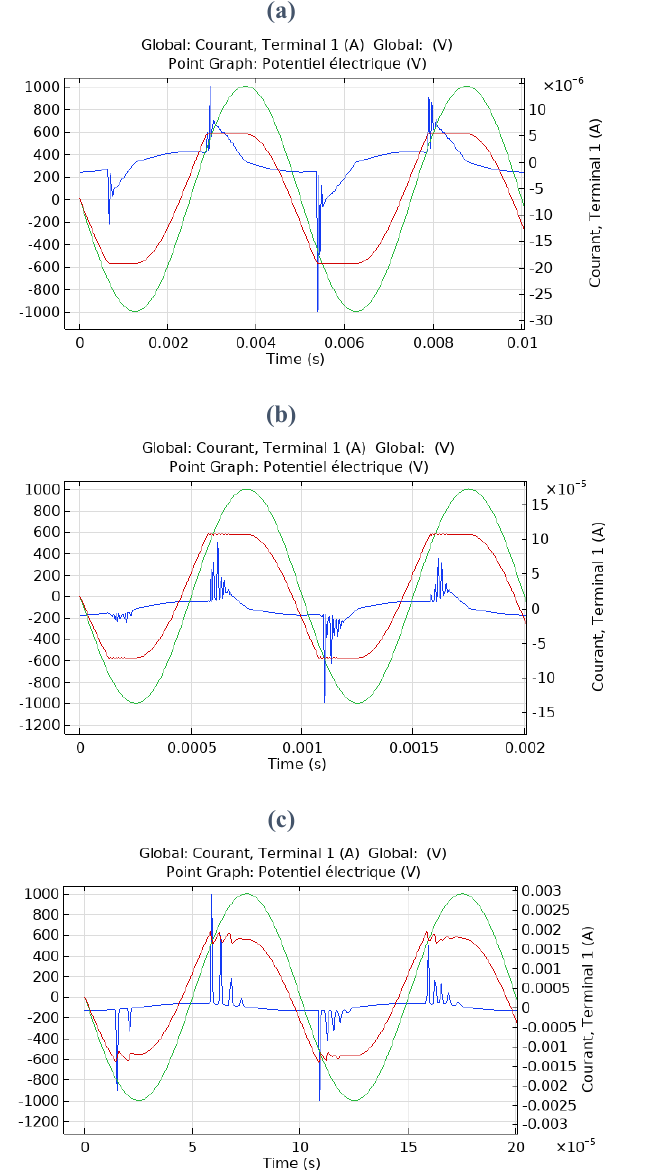
fig 5 : the variation of the breakdown voltage (in red) and of the electric current (in blue) as a function of the applied voltage (in green) with d = 0.5 mm and P = 760 Torr at different frequencies (a) 200Hz, (b) 1kHz and (c) 10kHz.